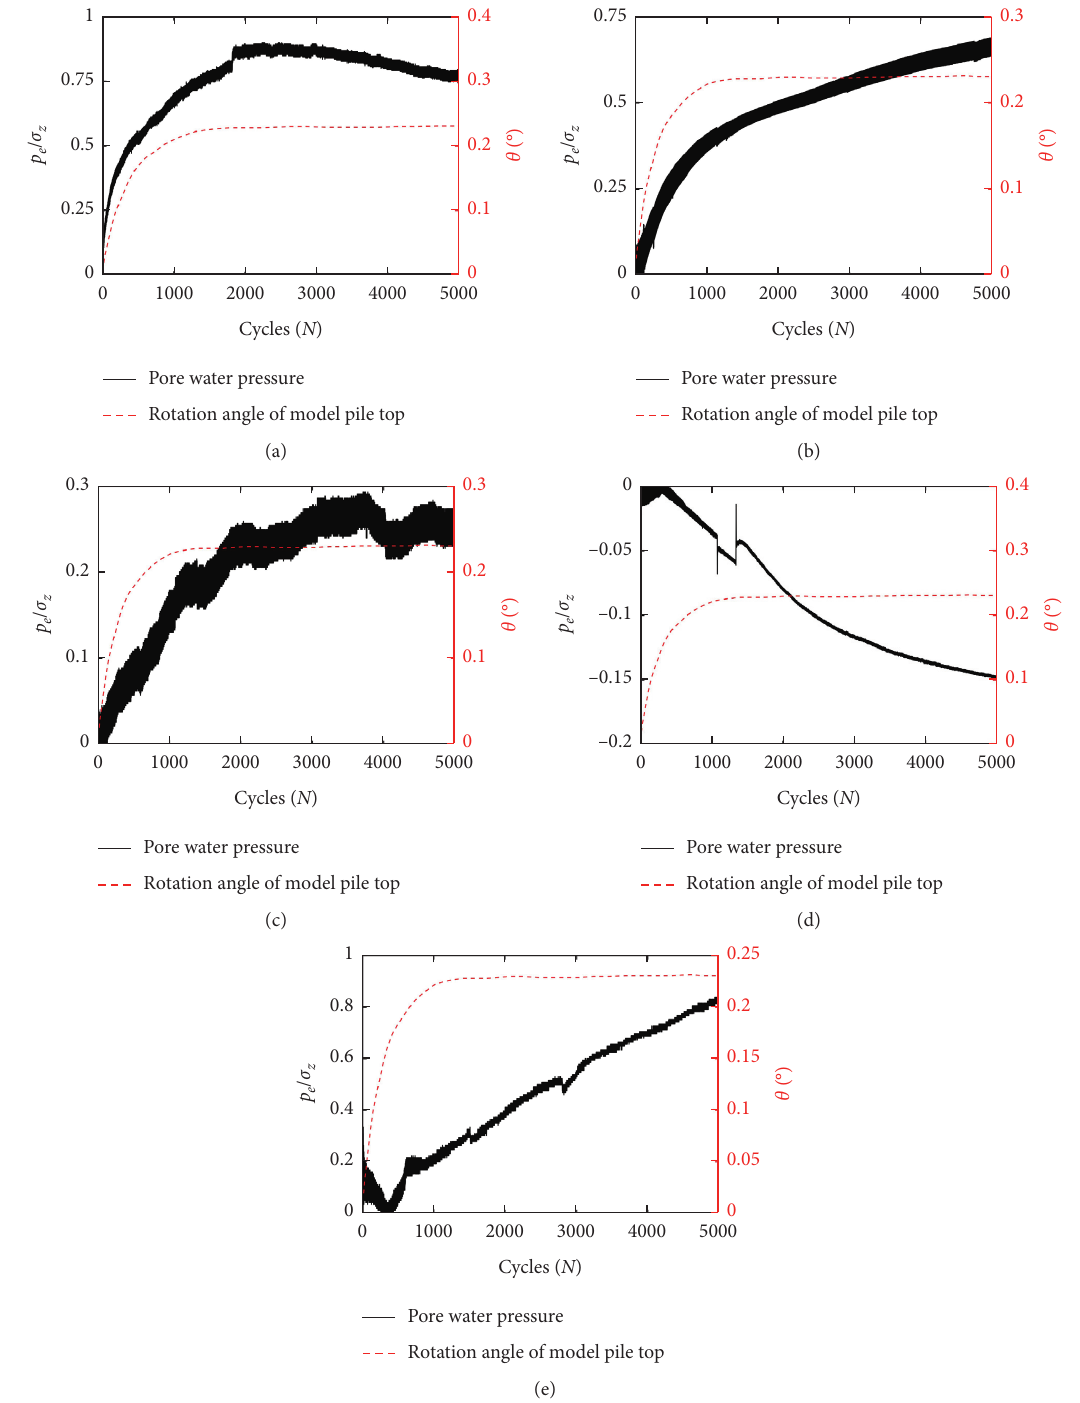
Figure 15: Variation in pore water pressure: (a) P 1; (b) P 2; (c) P 3; (d) P 4; (e) P